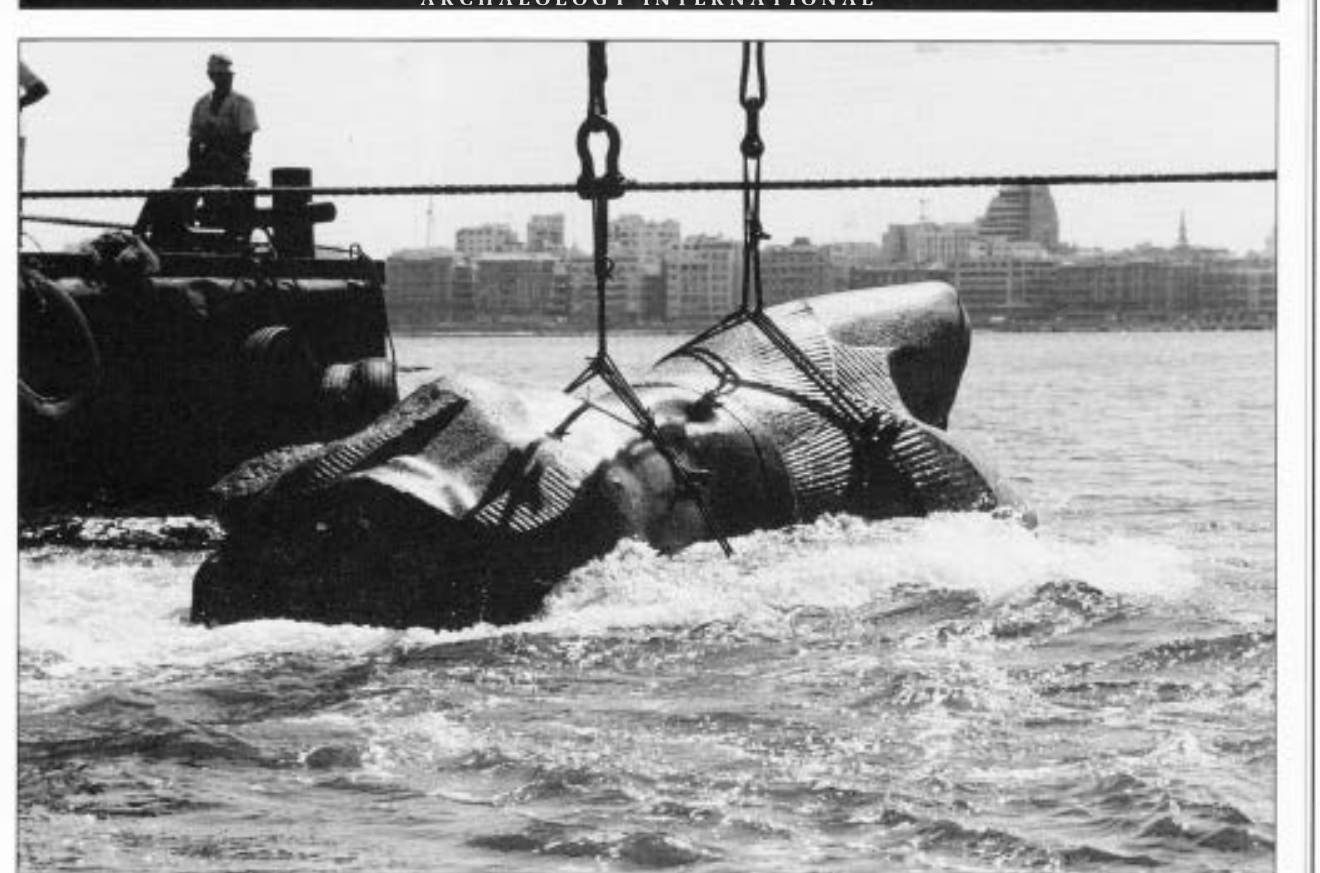
Figure 2 Hoisting a colossal Ptolemaic statue from the seabed; downtown Alexandria in the